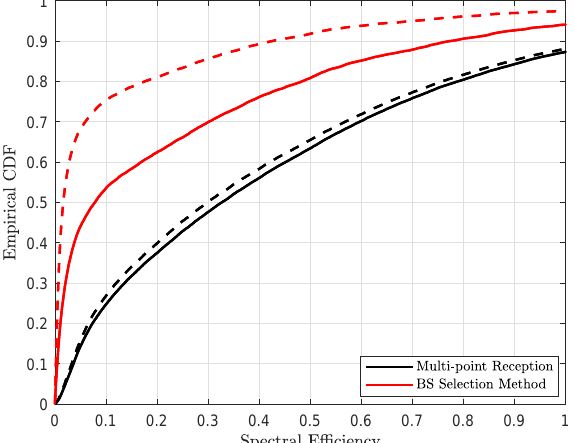
Figure 10. Achievable spectral efficiency as a function of increasing link blockage probability P b with the uplink transmit power P t = 15 dBm for multi-point reception (solid line) and BS selection method (dashed line).